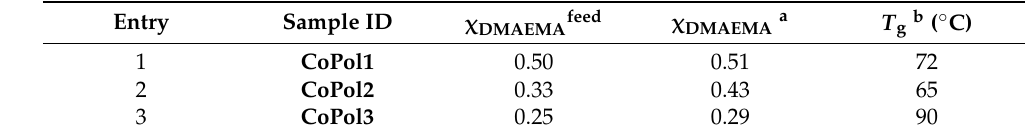
Table 1. Synthesis of P(MMA- ran -DMAEMA) copolymers by